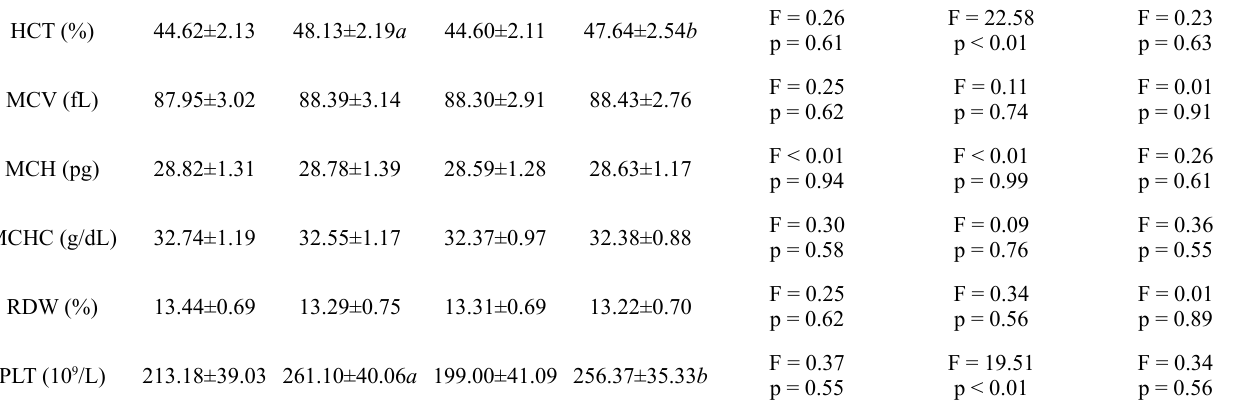
Table II. Results from biochemical parameters at rest and after time to exhaustion at maximal aerobic capacity intensity after placebo or melatonin. PR PEx MR MEx TREATMENT EXERCISE INTERACTION